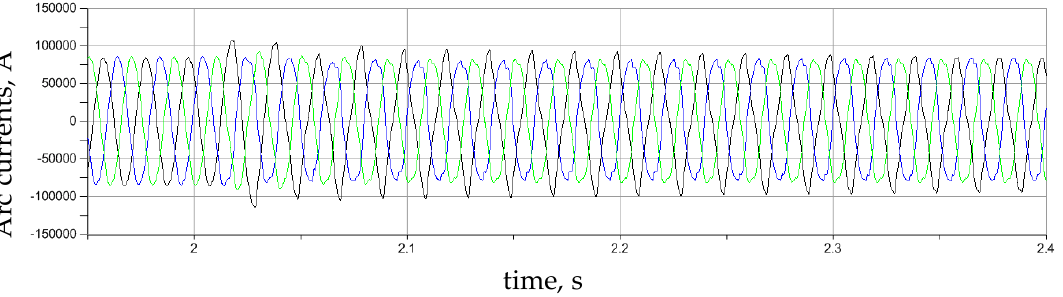
Figure 10. Arc currents during perturbation in phase A and in the case of choke control as a function of current: in phase A, in phase B, in phase C.